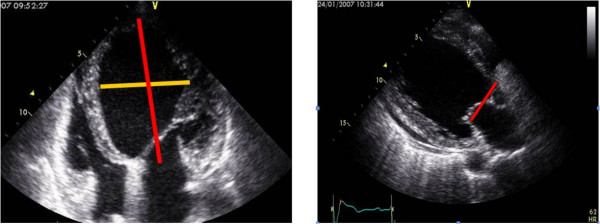
Measurement of LV sphericity index. LV sphericity index in apical 4-chamber view (3a), and C-septal distance in parasternal long-axis view (3b).